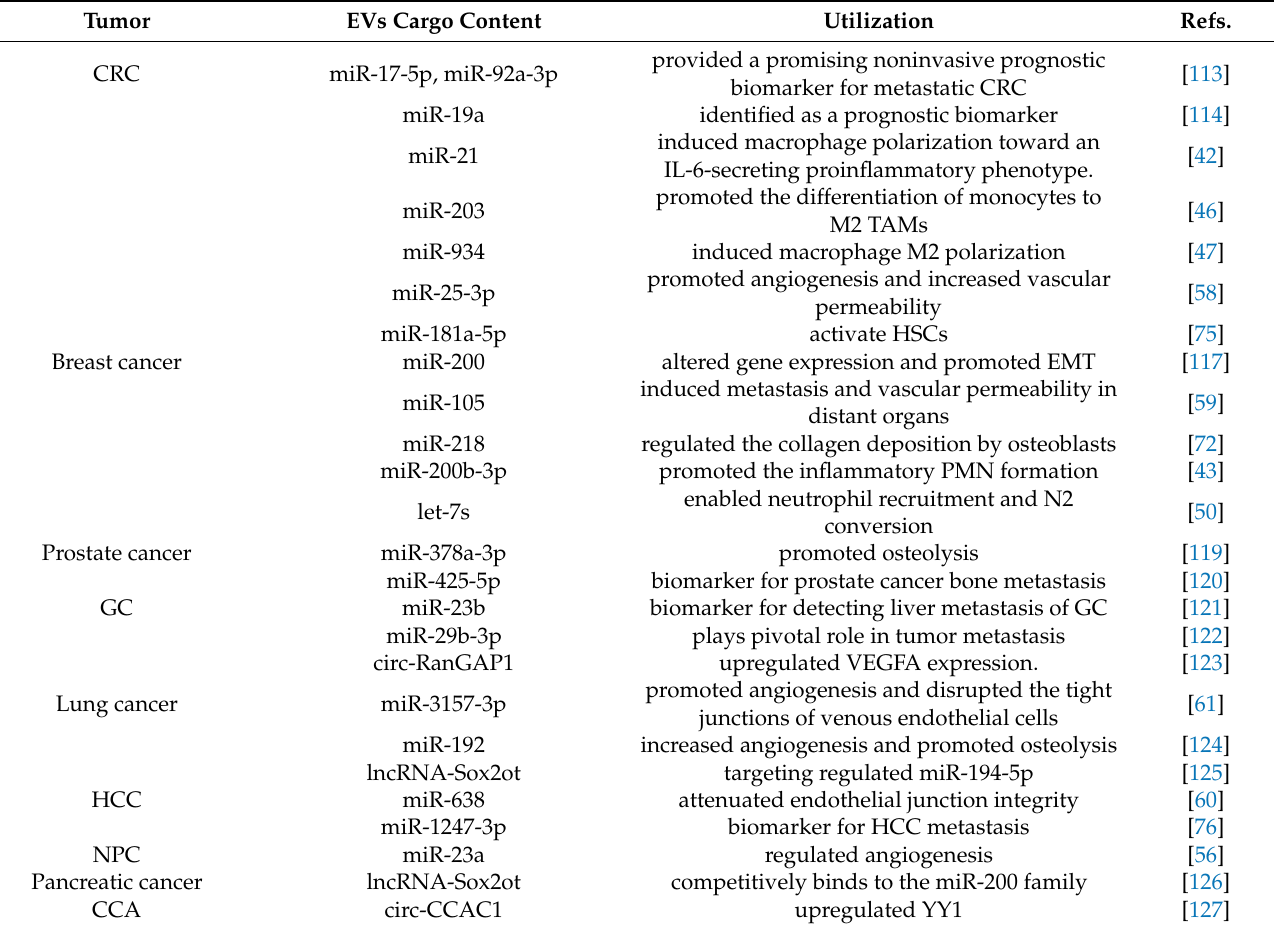
Table 1. NcRNAs carried by EVs may be biomarkers for predicting tumor